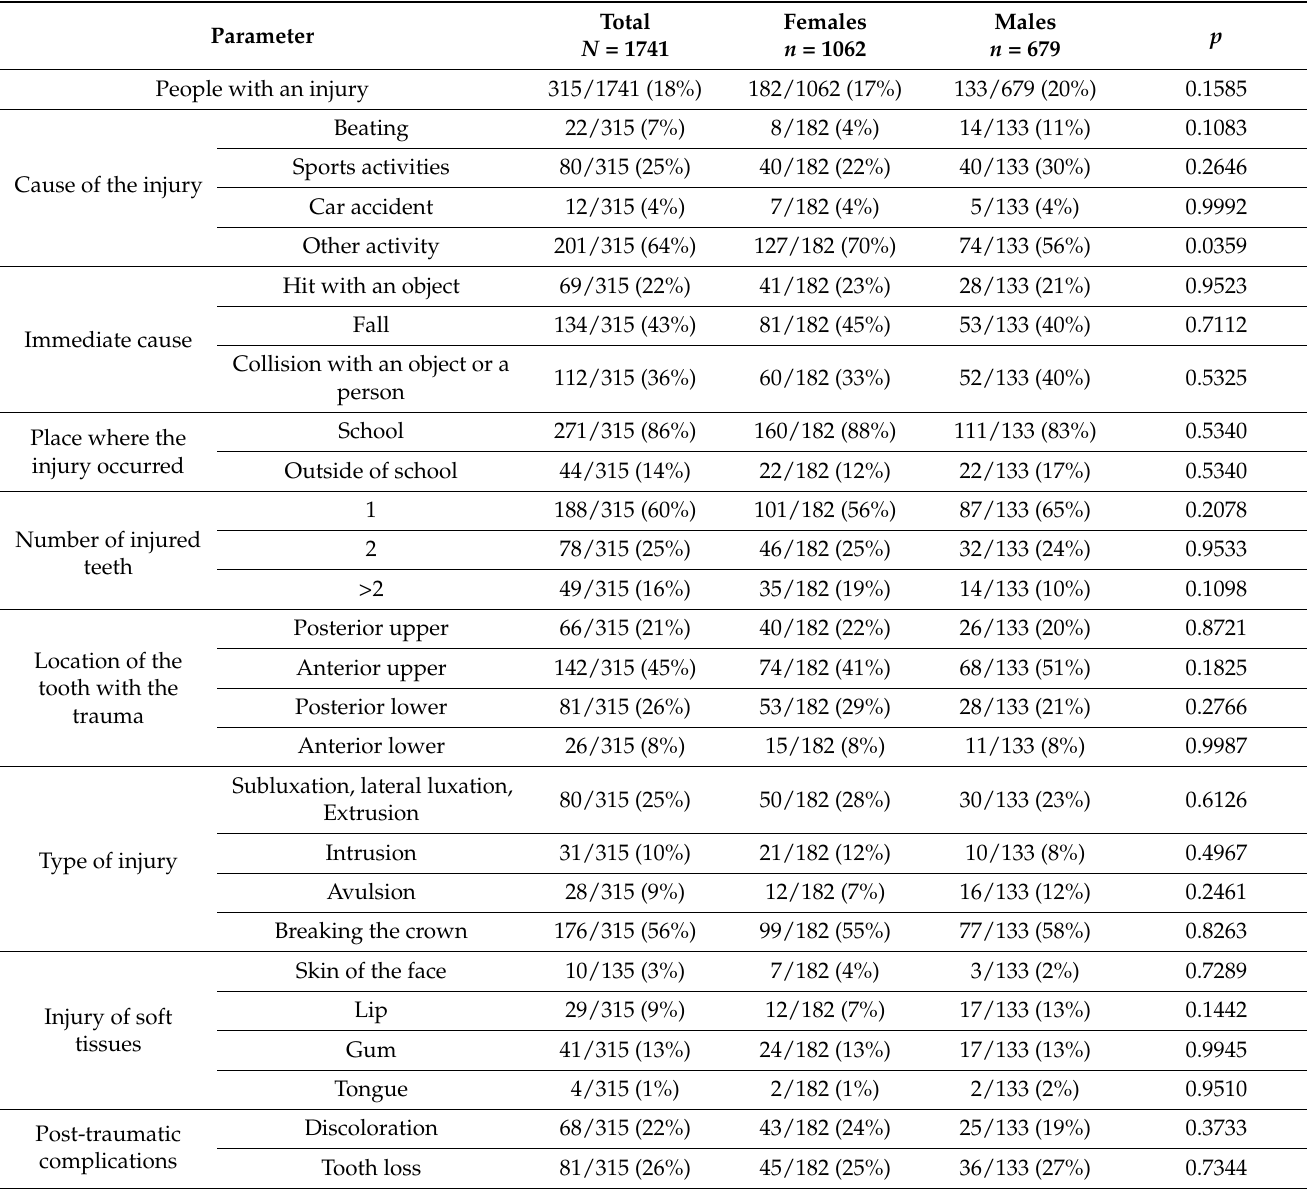
Table 1. Occurrence, type, causes, and place of trauma to permanent tooth/teeth, taking into account